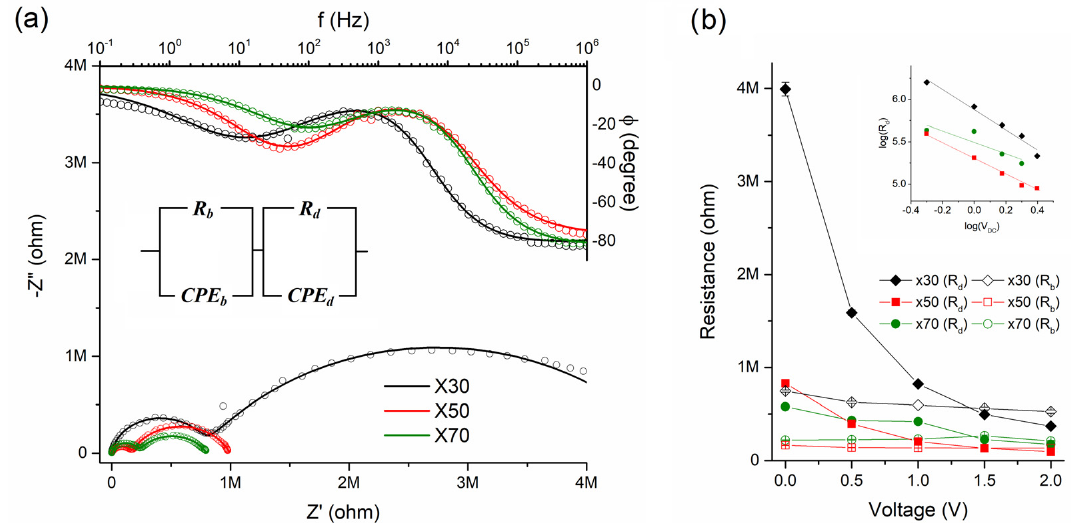
Figure 4. ( a ) Impedance spectroscopy displayed as Bode ( upper panel) and Nyquist ( lower panel) and ( b ) Bulk-region (R b ) and depletion-region (R d ) resistances as a function of applied dc voltage (V DC ) and log(R d ) vs. log(V DC ) plots (inset) for ×30, ×50 and ×70. The larger resistance process related to the dependence of the interface-depleted re- gion resistance (R d ) on the applied DC voltage can be shown by the slope ( − m ) in the